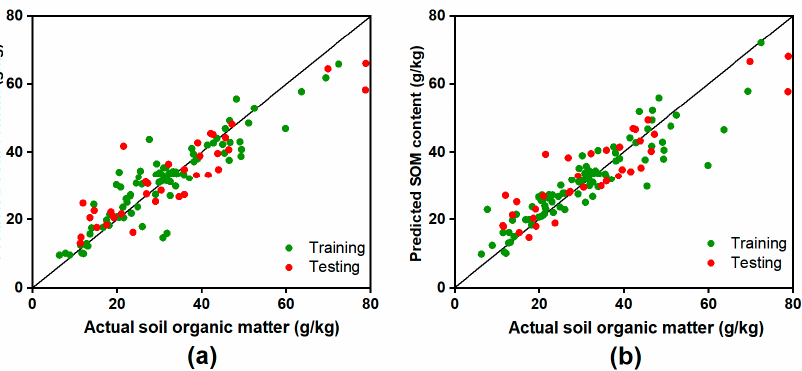
Figure 6. The prediction plots of SOM content by the PLSR model established by ( a ) PCC; ( b ) One- Way ANOVA.